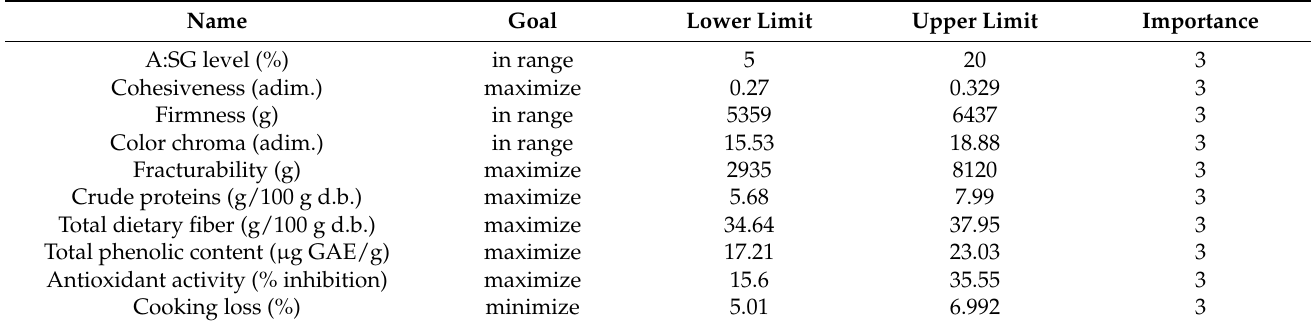
Table 3. Optimization constraints for pasta recipe.